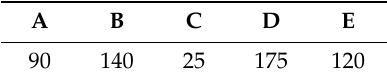
Table 2. Length parameters of cable joint (mm).